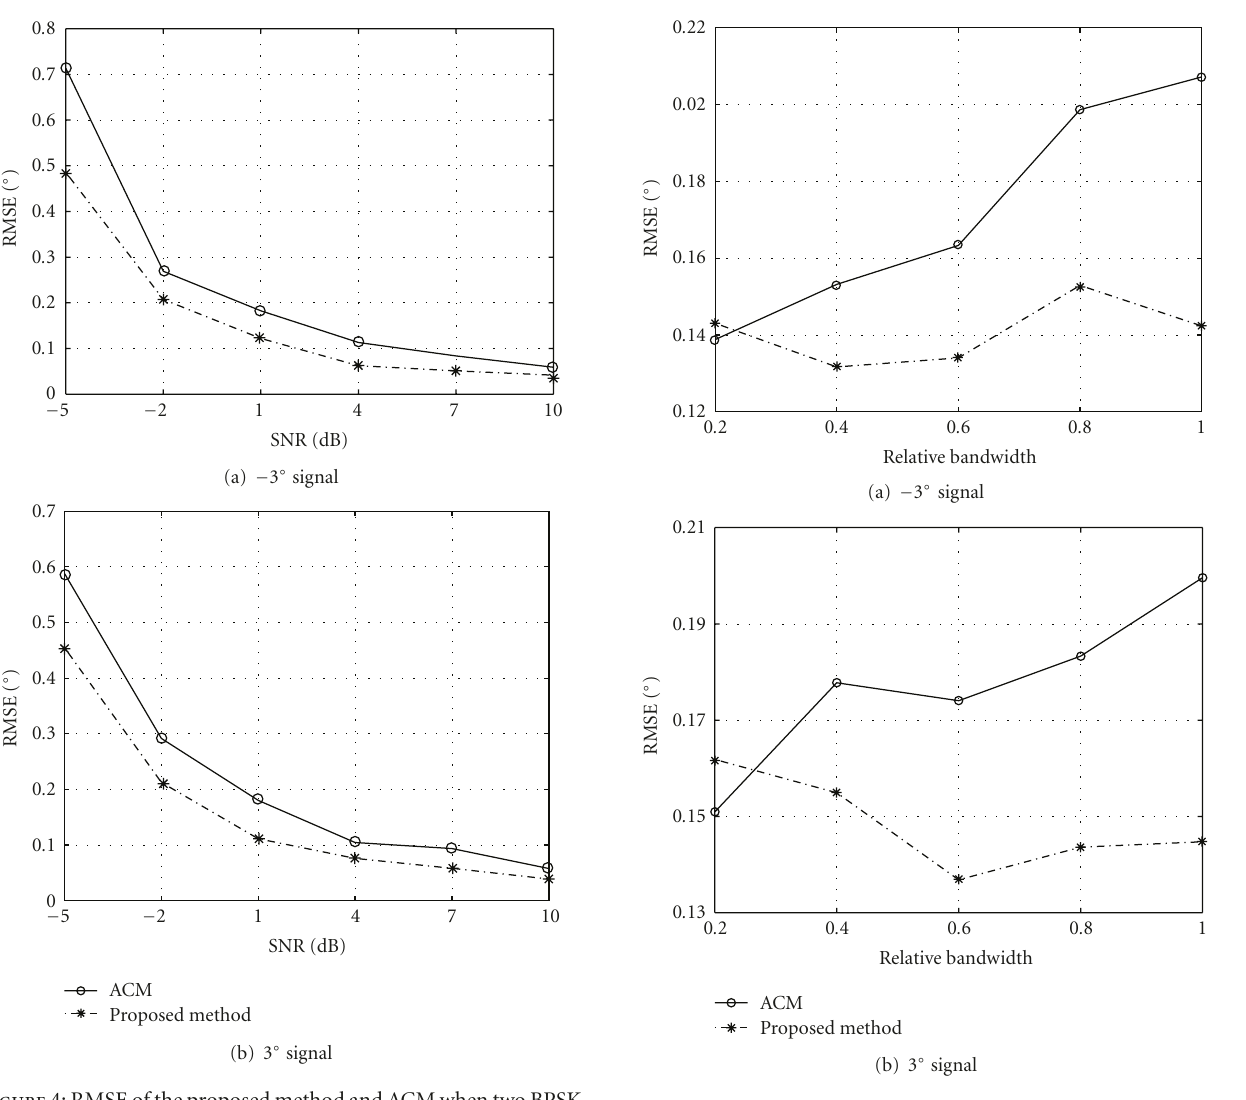
Figure 5: RMSE of the proposed method and ACM when two BPSK signals with SNR of 0dB impinge onto the